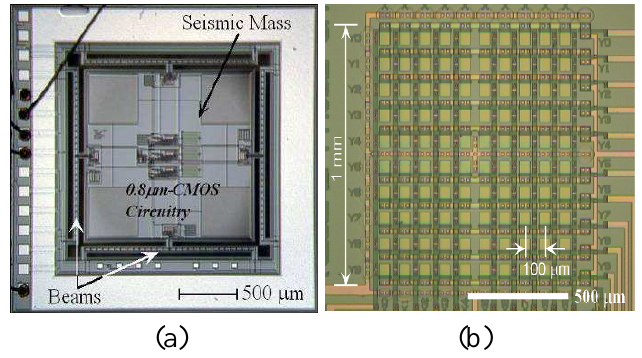
Figure 2. Examples of CMOS-integrated microsensors developed by our research group, (a) CMOS-integrated three-axis accelerometer [6], (b) Nerve potential sensor array